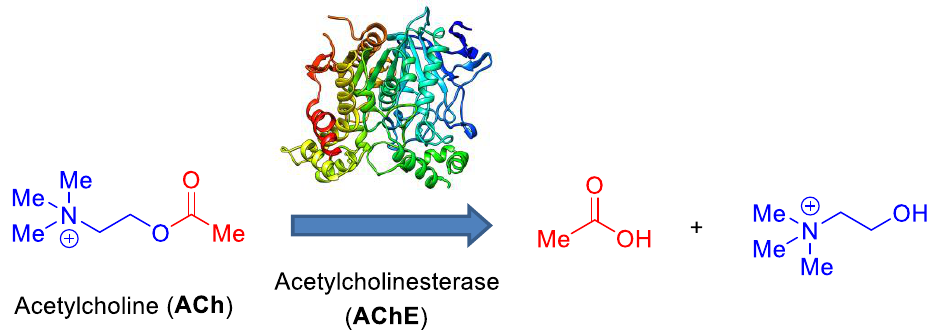
Figure 1. Structures of approved AChE inhibitors.